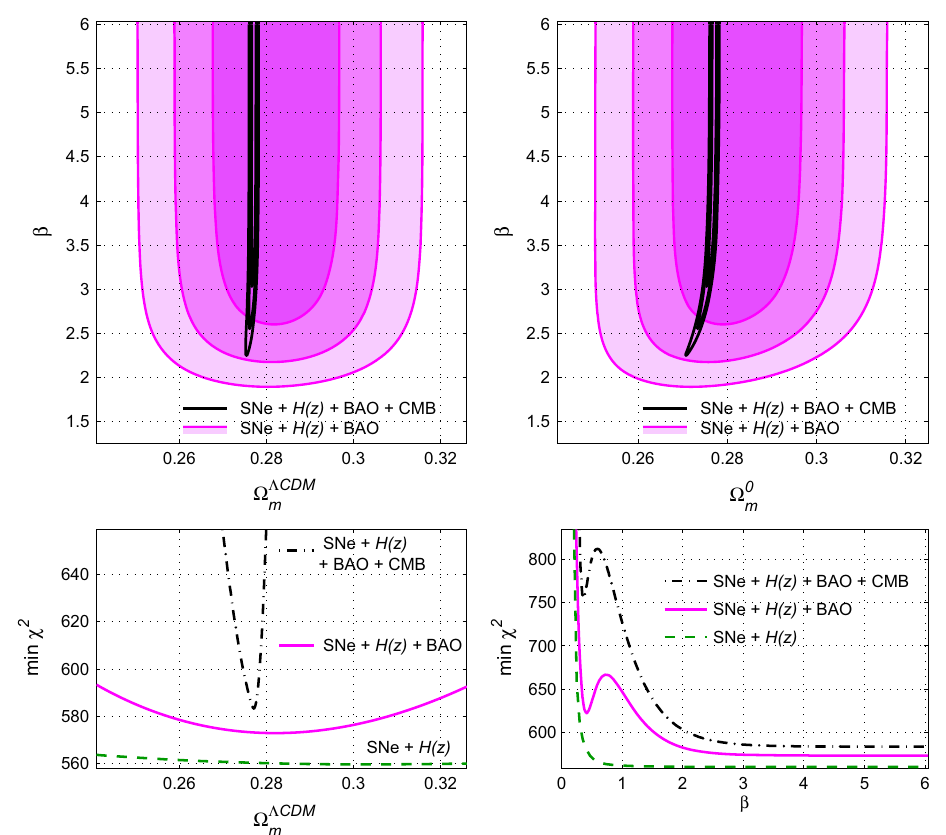
Fig. 1 Upper panels: contour plots for the free parameters of the expo- nential F ( R ) model (3.1) when assuming (cid:10) (cid:2) CDM m + (cid:10) (cid:2) CDM (cid:2) = 1, the leftpanelshowsthe (cid:10) (cid:2) CDM m − β planewhilethe (cid:10) 0 m − β planeisdepicted